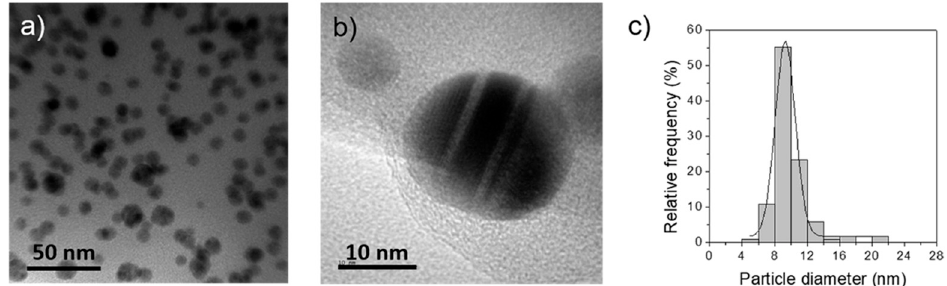
Figure 2. ( a , b ) Transmission electron microscopy images and ( c ) histogram depicting average particle distribution of AgNP. Average particle diameter, D p = 9.9 ± 2.2 nm.